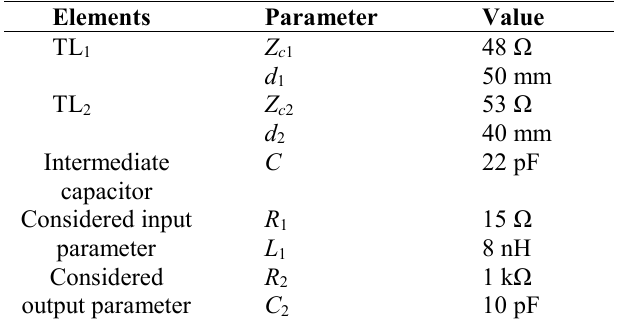
Table 3: Parameters of the POC circuit.